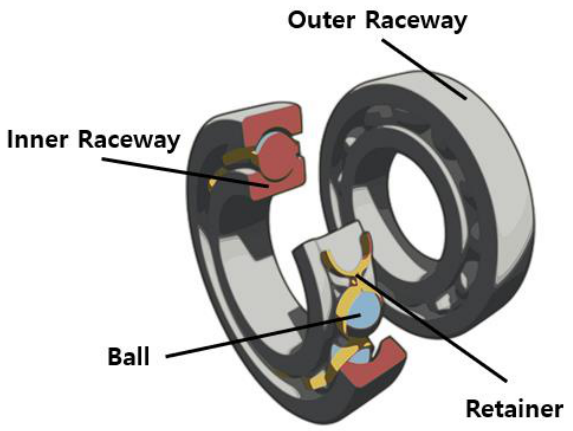
Figure 1. Components of rolling bearing.